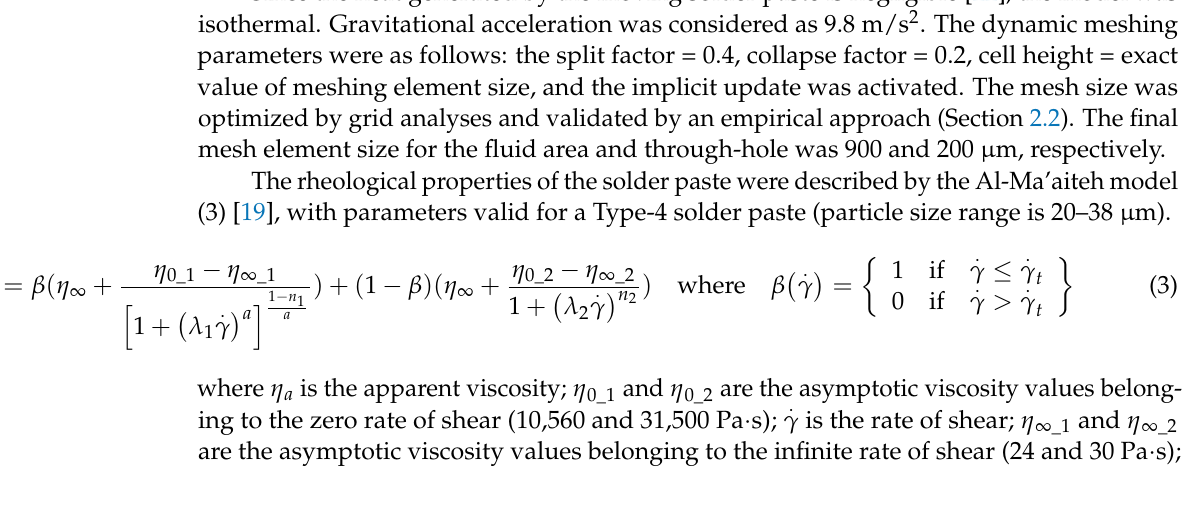
Figure 3. Boundary conditions of the numerical model.